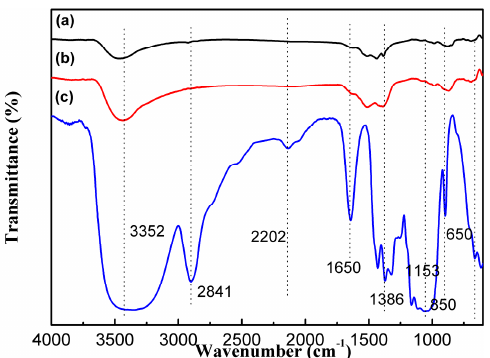
Figure 7. FT-IR of calcined treated Zr–ZnO ( a ), and Zr–ZnO before use ( b ) and after being used five times ( c ).